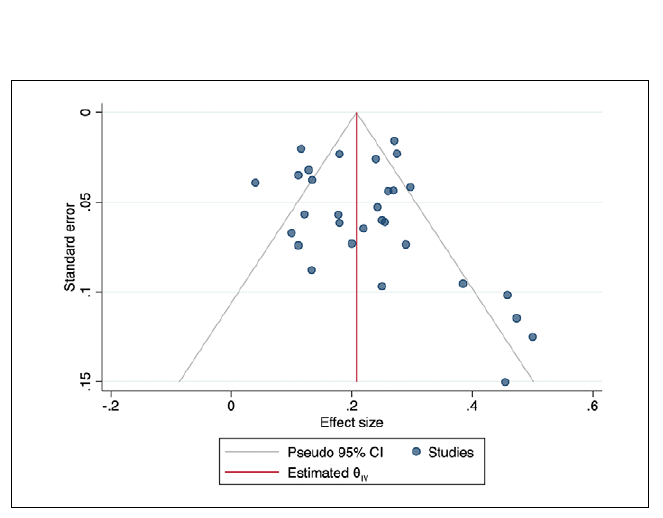
Figure 6. Funnel plot for mortality of kidney transplant recipients with COVID-19 infection.